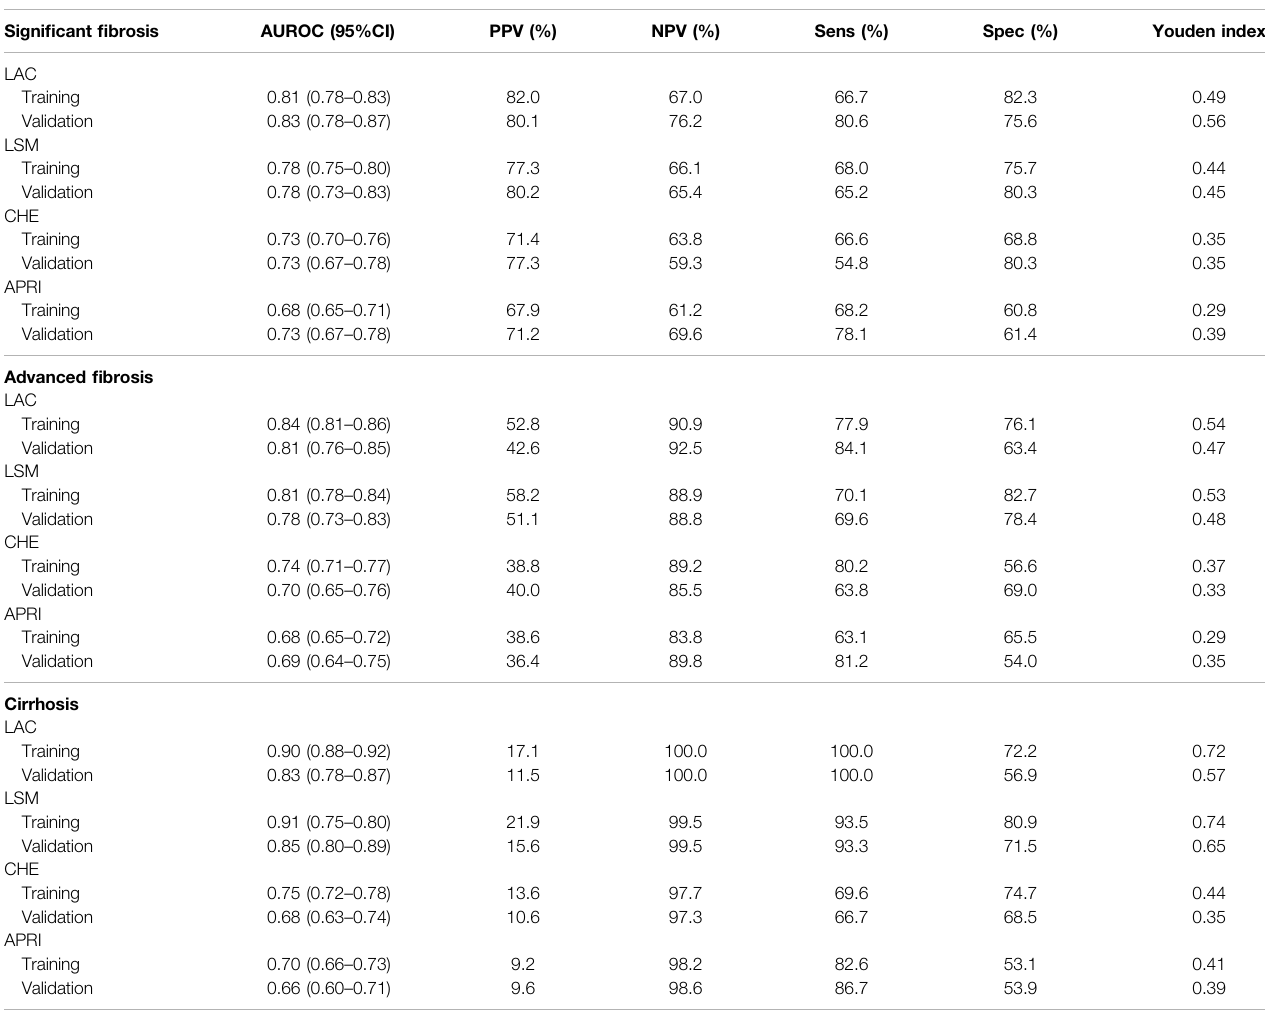
TABLE 3 | Diagnostic performance of LAC, LSM, APRI, and CHE in different fi brosis stages. Signi fi cant fi brosis AUROC